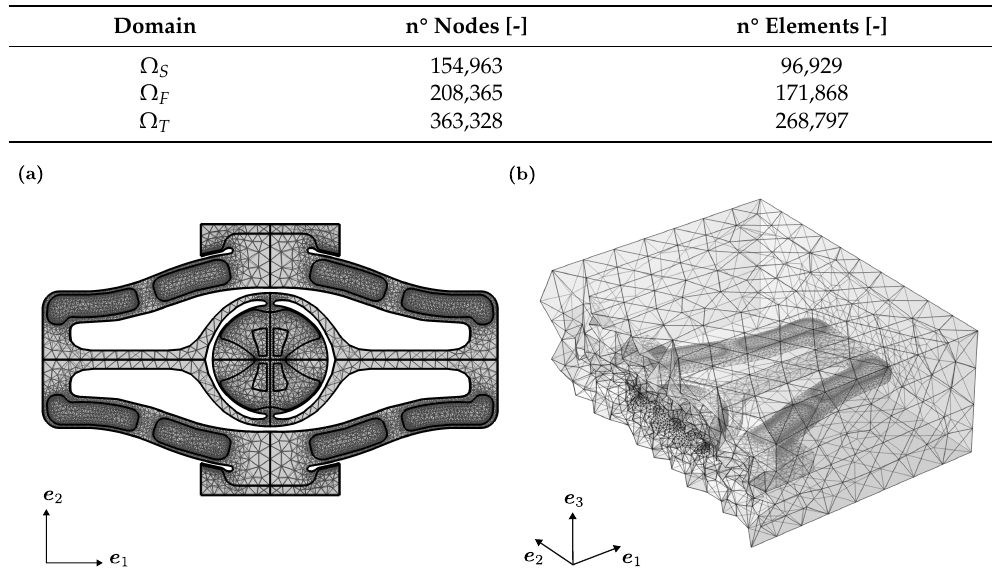
Table 4. Number of elements and number of nodes associated with solid, fluid, and full domain triangulation for Micromirror 2.